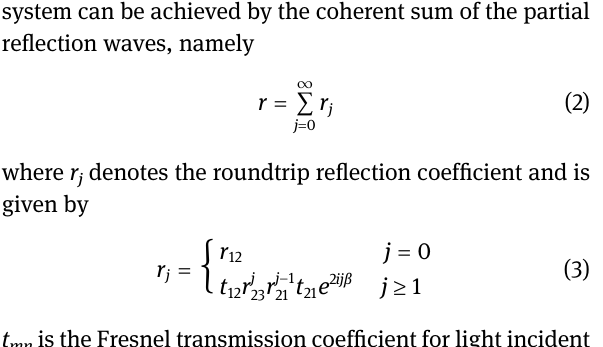
Figure 3: The multiple scattering model analyses. Schematic illustration of the light propagation in a deep subwavelength absorbing film on an opaque metallic